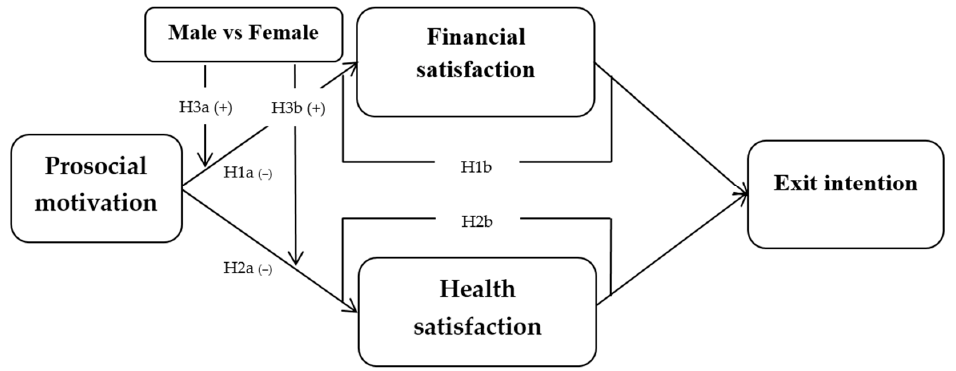
Figure 1. Conceptual model.